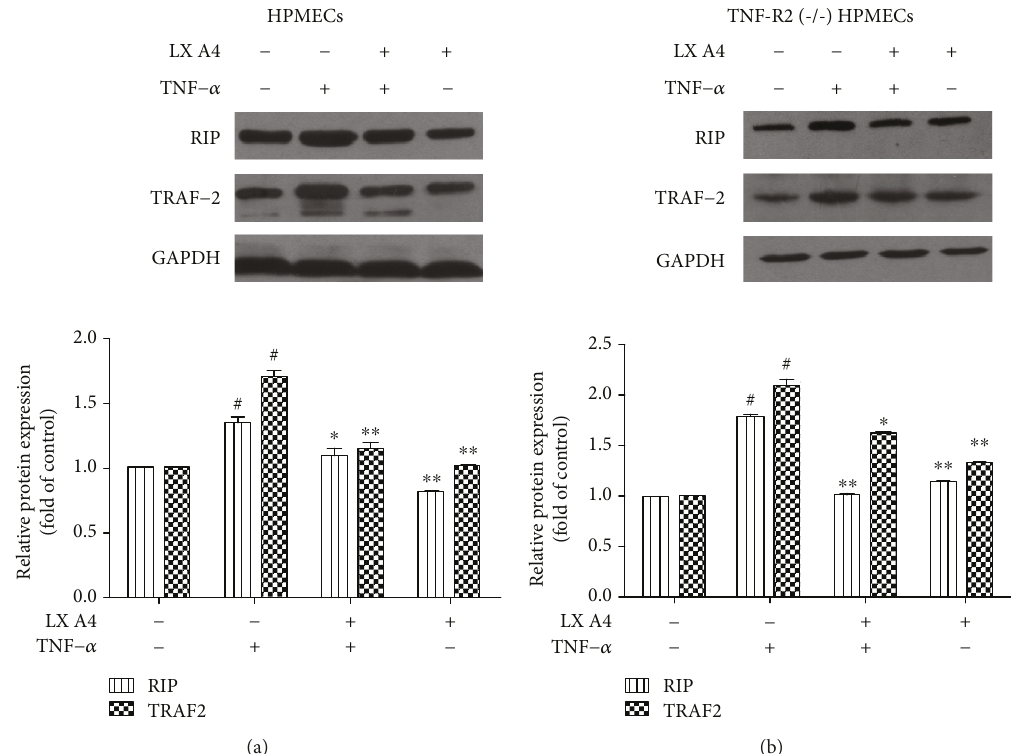
Figure 2: AT-Lipoxin A4 downregulation of RIP and TRAF2 expression in TNF- α -stimulated HPMECs and TNF-R2 (-/-) HPMECs. HPMECs and TNF-R2 (-/-) HPMECs were pretreated with AT-Lipoxin A4 (50 ng/mL) for 1h followed by incubation with TNF- α (50 ng/mL) for 6h. (a) Western blot assay shows expression of RIP and TRAF2 in HPMECs. (b) Western blot assay shows expressions of RIP and TRAF2 in TNF-R2 (-/-) HPMECs. GAPDH was used as an internal control. The data showed representatives of at least three independent experiments. # P < 0 01 compared with the control, ∗ P < 0 05 compared with TNF- α in the absence of AT-Lipoxin A4, and ∗∗ P < 0 01 compared with TNF- α in the absence of AT-Lipoxin